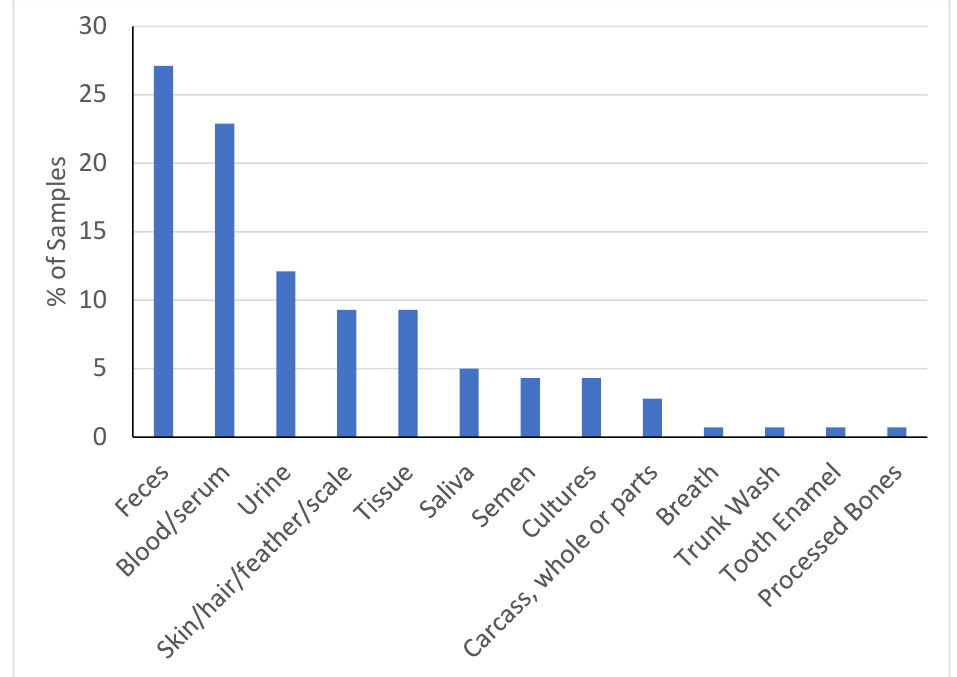
Figure 1. Percentages of different biomaterial types zoos agreed to provide to researchers in the convenience sample of zoos in this